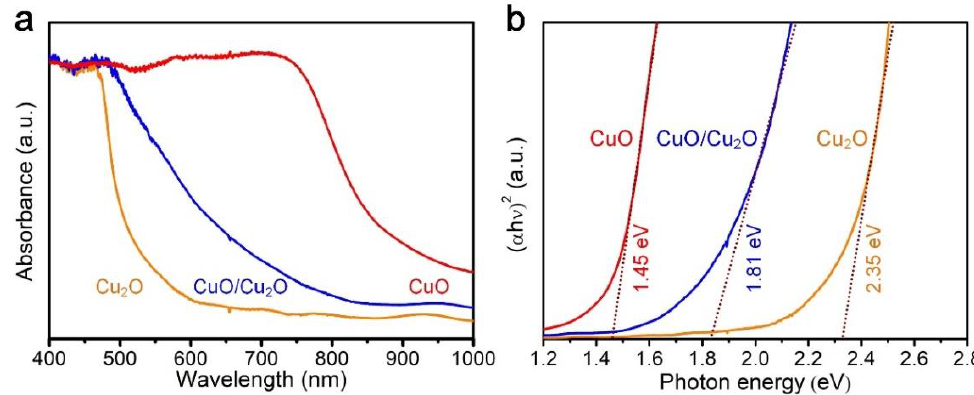
Figure 3. ( a ) Normalized absorbance spectra and ( b ) Tauc plots of Cu 2 O, CuO/Cu 2 O, and CuO thin films.